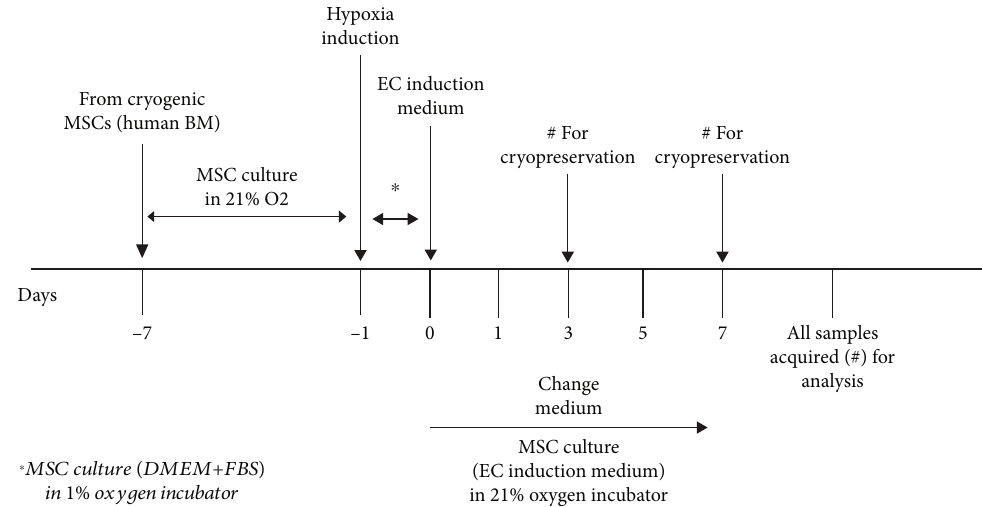
Figure 2: Protocol schedule for in vitro endothelial cell (EC) di ff erentiation challenge in mesenchymal stem cells (MSCs) vs. hypoxia- induced MSC (hi-MSC) models, follow-up, and acquisition of samples at day 3 and day 7 after application of EC-induction medium. 0.450.500.550.60